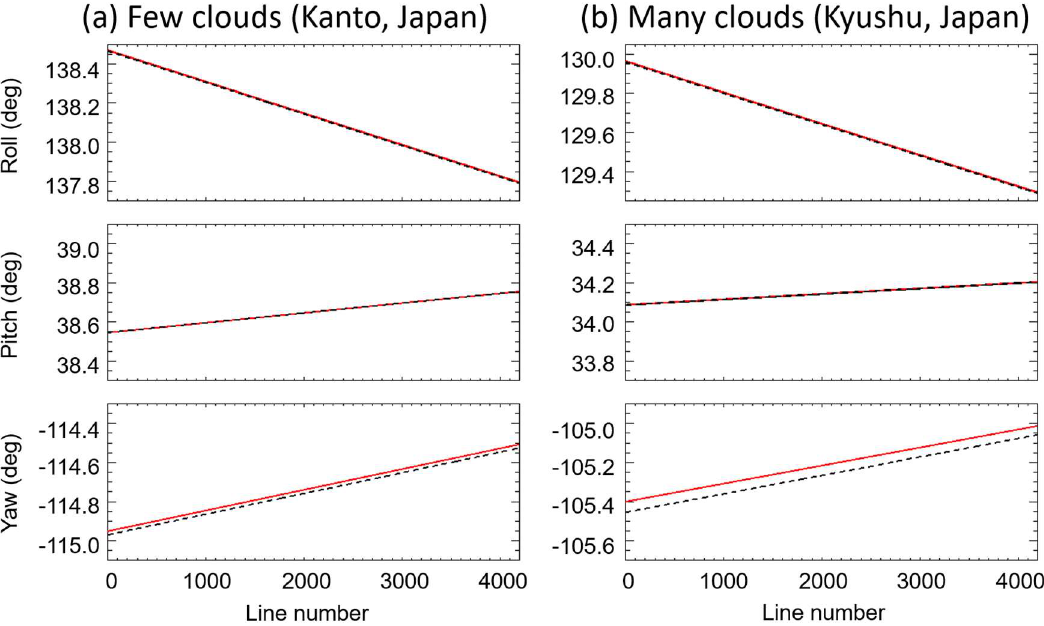
Figure 5. Derived temporal variations of ASTER attitude (roll, pitch, and yaw angles) during observations for cases of ( a ) few clouds and ( b ) many clouds in Figure 4. Solid lines indicate sensor attitude measured from proposed method and dashed lines are from onboard attitude sensors of ASTER.